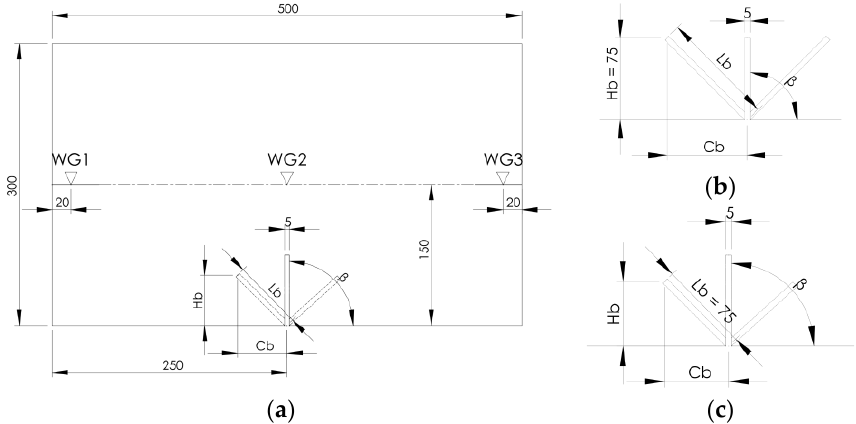
Figure 1. Tank schematic for ( a ) h =150 mm, L = 500 mm and ( b ) baffle configuration for fixed H b = 75 mm and ( c ) for fixed L b = 75 mms.